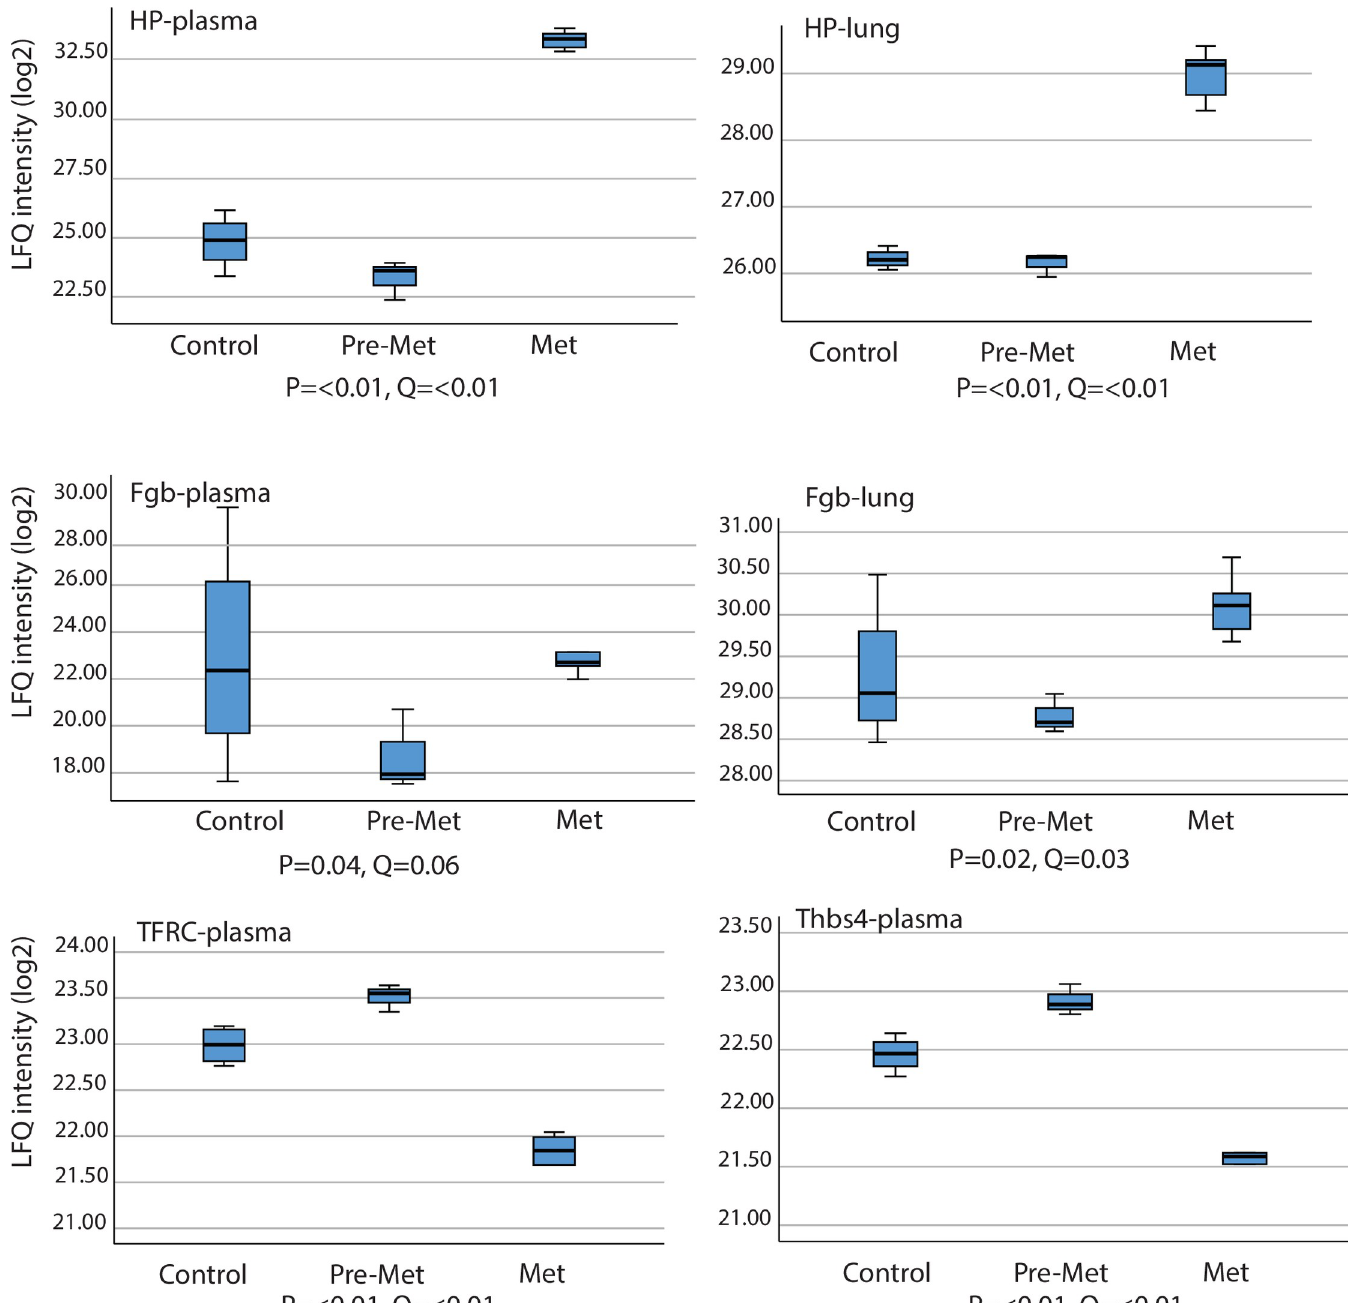
Fig 5. SPSS box plot to show the distribution (median, first quartile, third quartile, minimum and maximum value) of the LFQ intensity data for four potential biomarkers for metastatic breast cancer, including haptoglobin, fibrinogen beta chain, thrombospondin-4, and transferrin receptor protein.